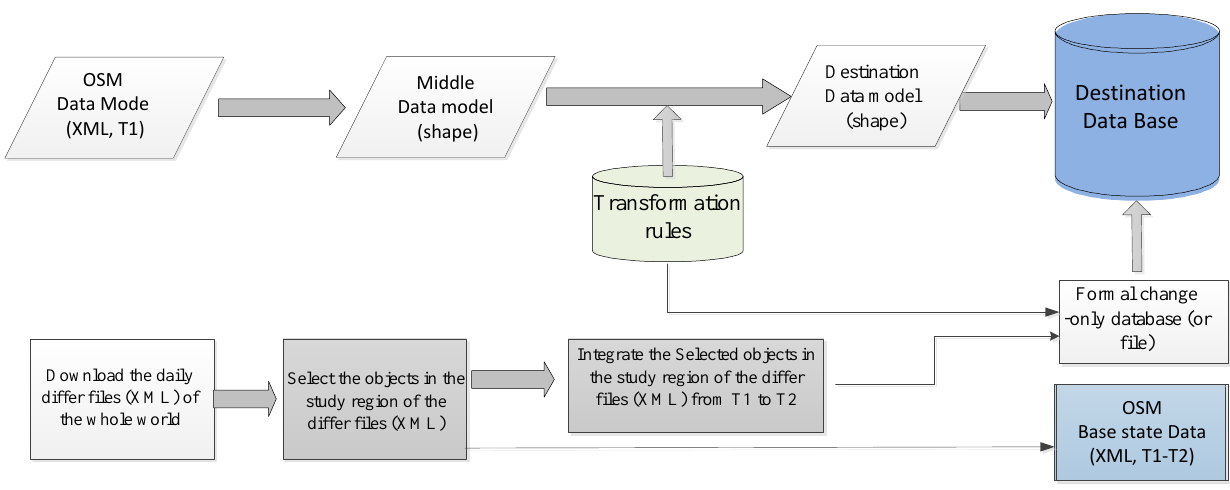
Figure 1. The strategy for dynamically integrating a borderland database using OSM